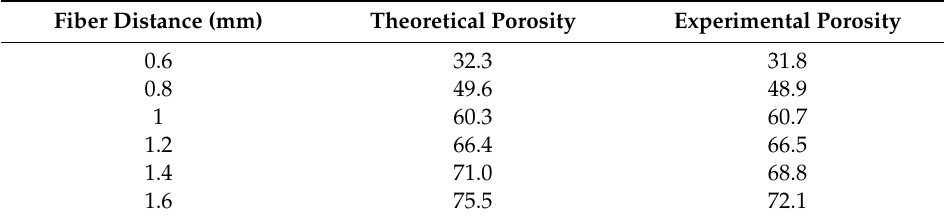
Table 3. The theoretical porosity and the measured porosity of sca ff olds.